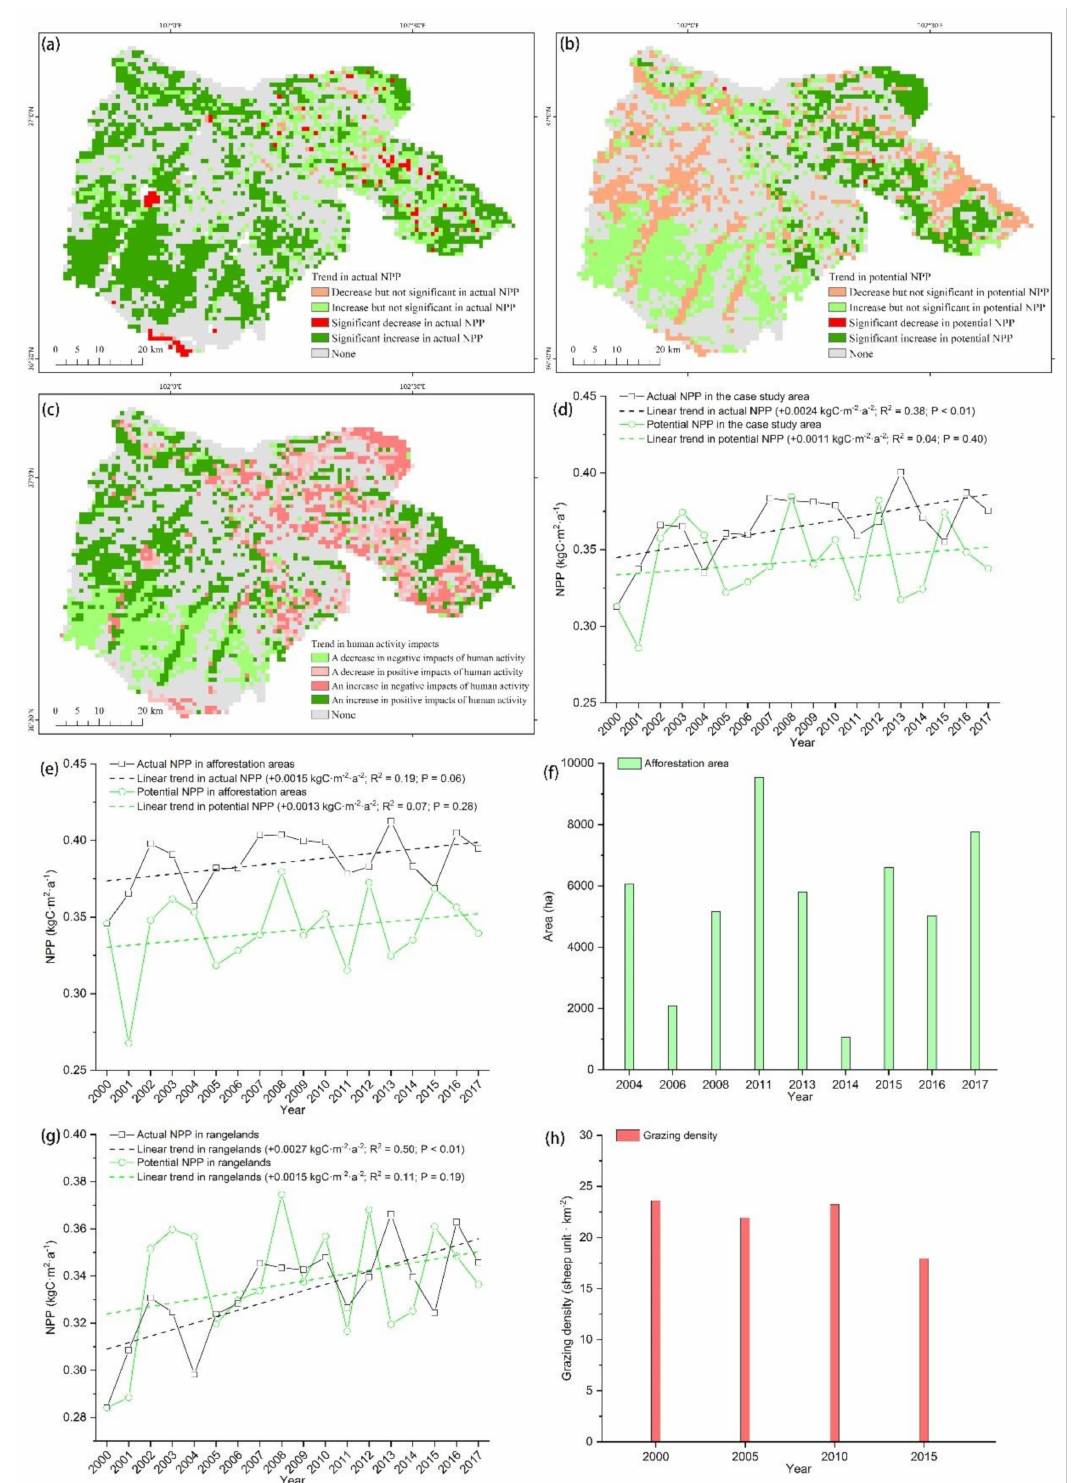
Figure 6. Trends in NPP and human activity changes in the case study area during 2000–2017. Trends in ( a ) actual NPP, ( b ) potential NPP and ( c ) the impact of human activity, respectively. Gray areas marked with “None” means that trends in actual and potential NPP were all insignificant. ( d ) Trends in NPP at the entire HZ scale. ( e ) NPP trends in the afforestation areas and ( f ) afforestation area during 2004–2017. ( g ) NPP trends in the rangelands and ( h ) grazing density during